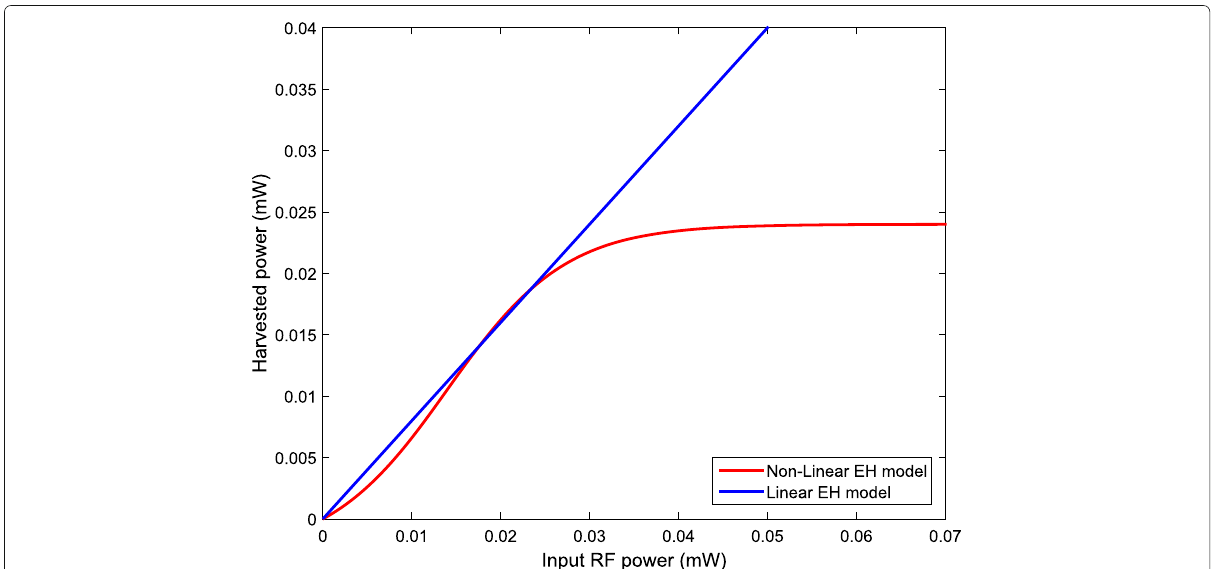
Fig. 2 A comparison between the linear EH model and the non-linear EH model. For linear EH model, η = 0.8, for non-linear EH model [28, 29], P s = 0.024 mW, a = 150, and b = 0.014